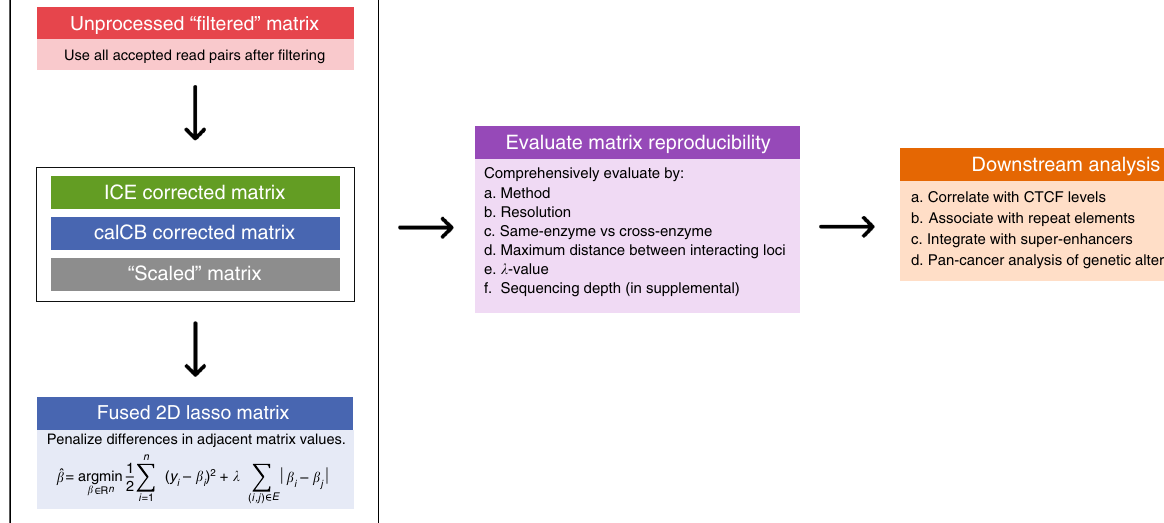
Fig. 1 Overall work fl ow and benchmarking strategy. Our analysis starts with unprocessed Hi-C contact matrices. We then generate processed Hi-C matrices using ICE “ correction ” , our “ scaling ” approach and calCB. Fused two-dimensional lasso is applied on the processed Hi-C matrices. Matrix reproducibility between biological replicates is assessed across samples for a variety of parameters using stratum-adjusted correlation coef fi cients 21 . Finally, downstream analysis, involves the characterization of TAD boundaries based on their insulating strength, the enrichment in CTCF binding, proximity to repeat elements and super-enhancers, and, their genetic alterations in